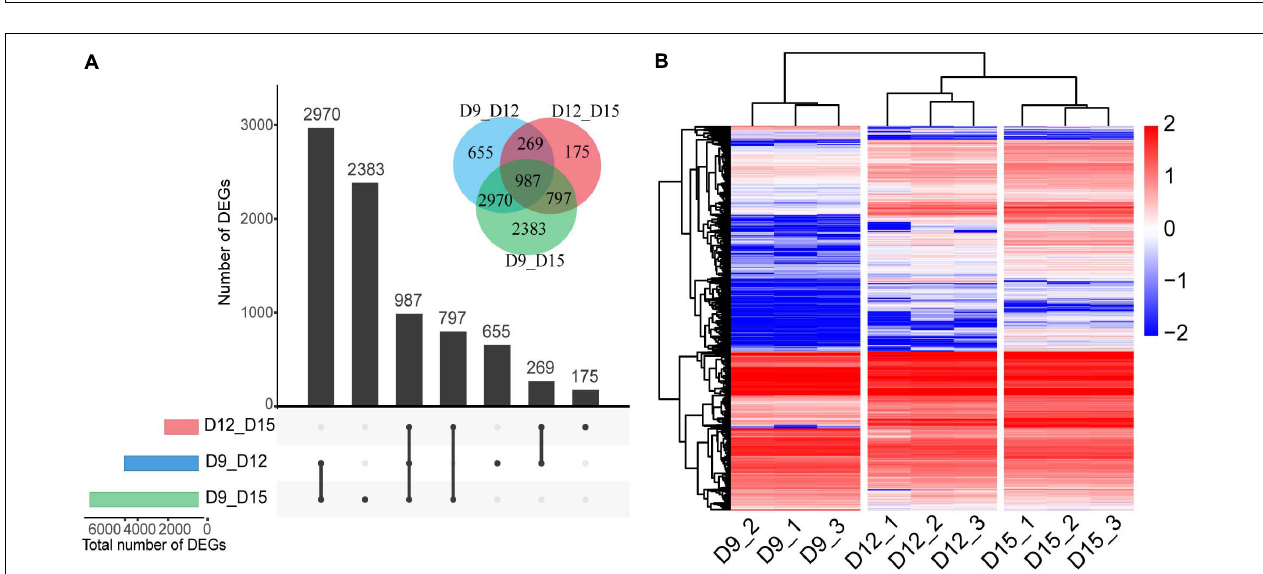
FIGURE 2 | Differentially expressed genes (DEGs) of the porcine conceptus across three periods of pregnancy. Upset plot and Venn diagram illustrating the number of DEGs across the three developmental phases (A) . Red, day 12 vs. day 15 of conceptus; blue, day 9 vs. day 12 of conceptus; and green, day 9 vs. day 15 of conceptus. Hierarchical cluster analysis of DEGs identified for three phases (B) . The color scale is from -2.0 (blue, lower gene expression) to 2.0 (red, higher gene expression). Each row represents one gene, each column represents one sample.